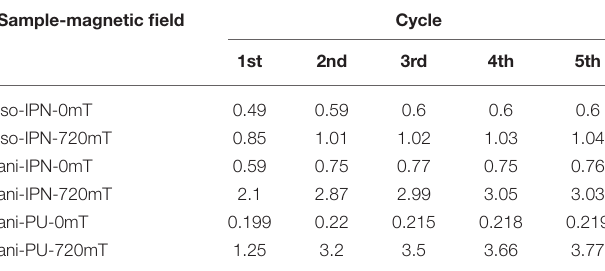
TABLE 5 | Fitting parameter m (a.u) of the samples in the different cycles. Sample-magnetic